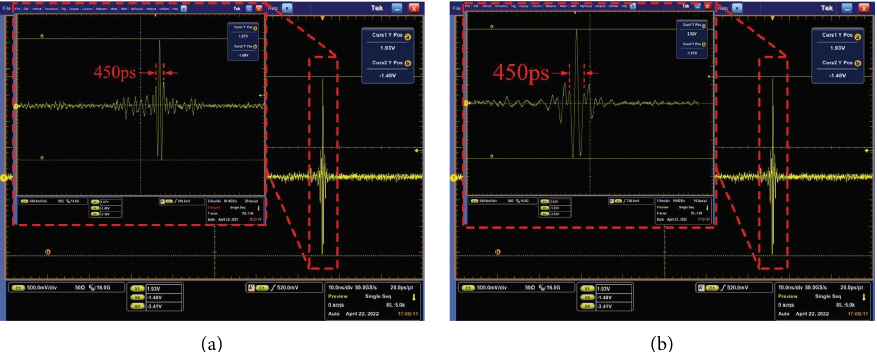
Figure 10: Te measured compressed USP signal waveforms of the input pulse with diferent time lengths. (a) Te measured compressed USP signal waveform of the input pulse with 2 μ s time length. (b) Te measured compressed USP signal waveform of the input pulse with 7 μ s time length.